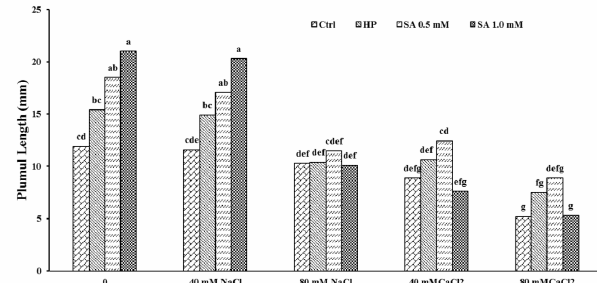
Fig. 2. Mean comparisons of the interaction of priming and salinity on plumule length). Ctrl: control (no priming), HP (hydro priming), SA (salicylic acid). Different letters on columns refer to significant differences between treatments at 5 % level according to LSD Test and 1 mM SA seed priming treatments only at level of 40 mM NaCl salinity showed such behavior (Fig.